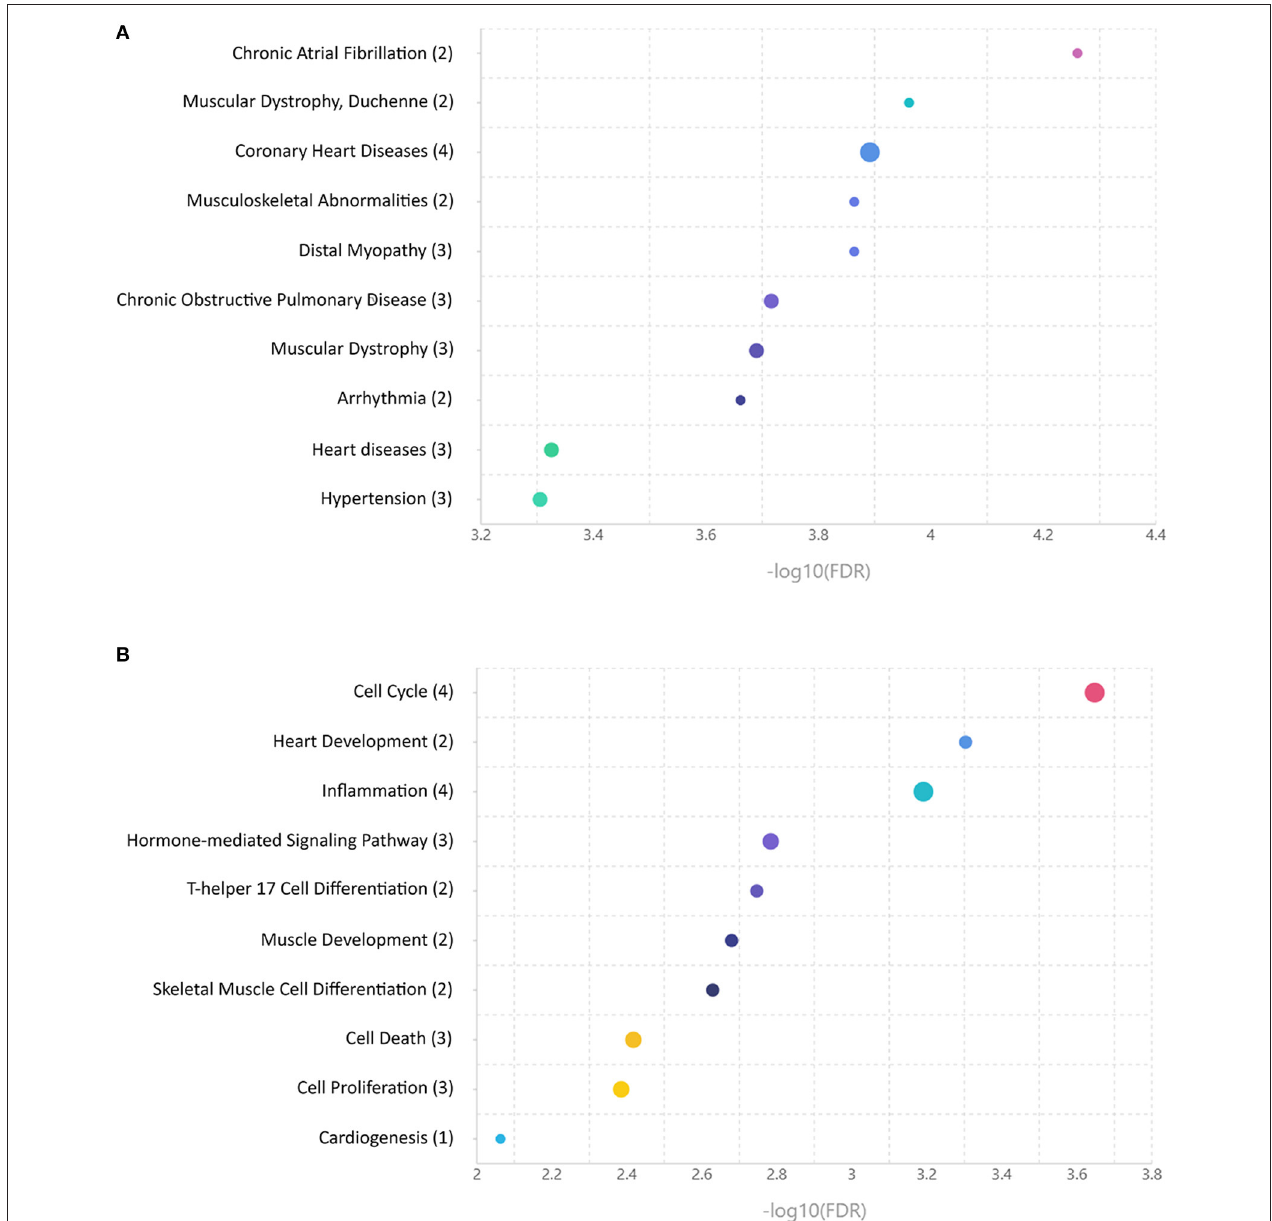
FIGURE 2 | Enrichment analyses of microRNAs differentially expressed between control and arrhythmogenic right ventricular cardiomyopathy (ARVC) pericardial fluid samples. (A) MicroRNA set mapping against database containing disease-associated microRNA sets. (B) MicroRNA set mapping against database containing biological processes-associated microRNA sets. The number of microRNAs overlapping between the datasets is indicated in round